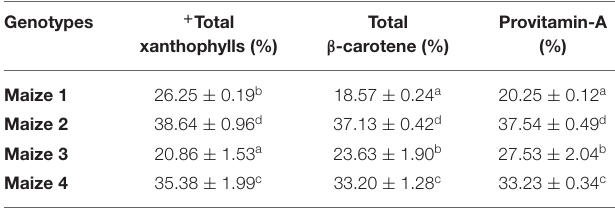
Values are mean ± SD of triplet determinations. + Values with different superscripts along the column are significantly different from one another (p ≥